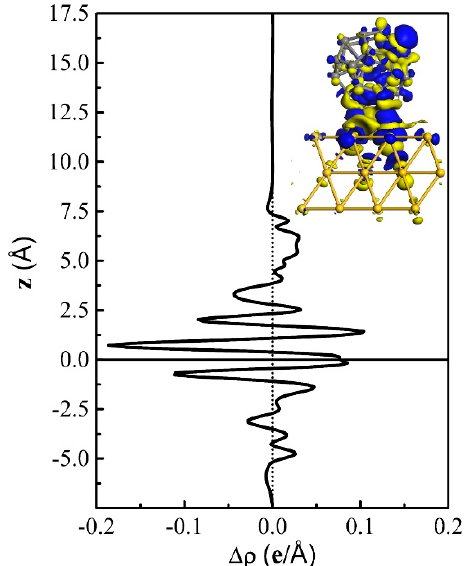
Figure 3. The xy -plane-averaged differential charge density is along the z direction. For simplicity, the z direction coordinates of the bottom Au layer are set to zero. Insert: differential charge density of the Fe@C 28 -Au adsorption configuration. The isovalue is set to ±0.008 e/Å 3 .